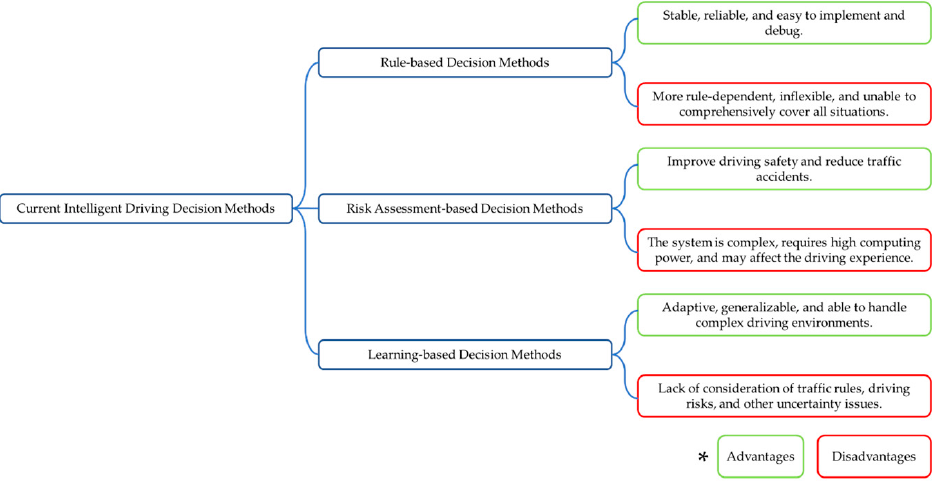
Figure 1. Advantages and disadvantages of different driving decision methods (* The green boxes represent advantages, and the red boxes represent disadvantages).